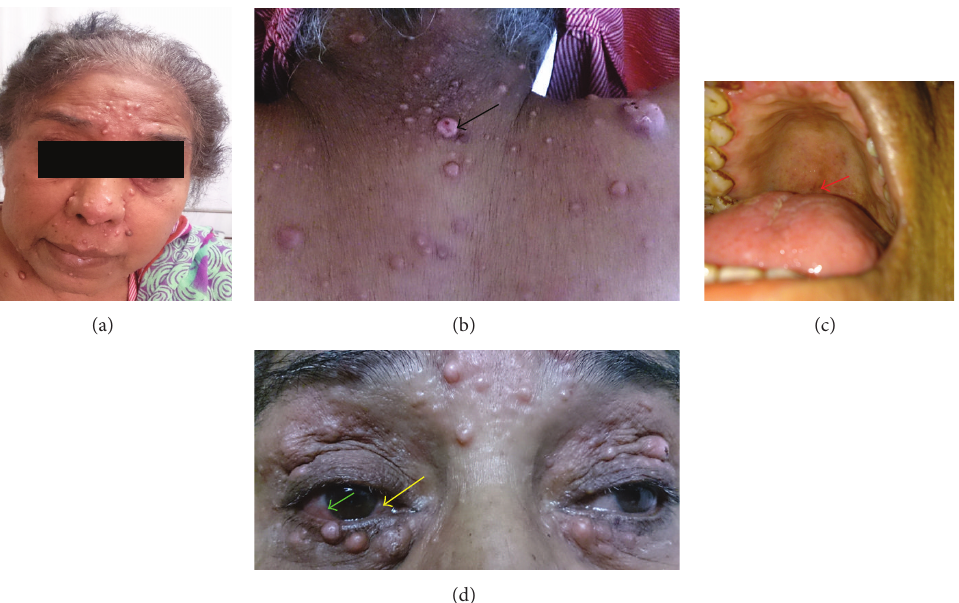
Figure 1: Clockwise, from left: nodular lesions involving the face in a disseminated pattern, mimicking lepromatous leprosy; the boggy pus draining lesions at the back with ulceronodular features (black arrow); eye involvement in the form of nodules on the conjunctiva (yellow arrow) and conjunctival suffusion (green arrow); mucous surface involvement in the form of broken down nodular lesion on the soft palate (red arrow).